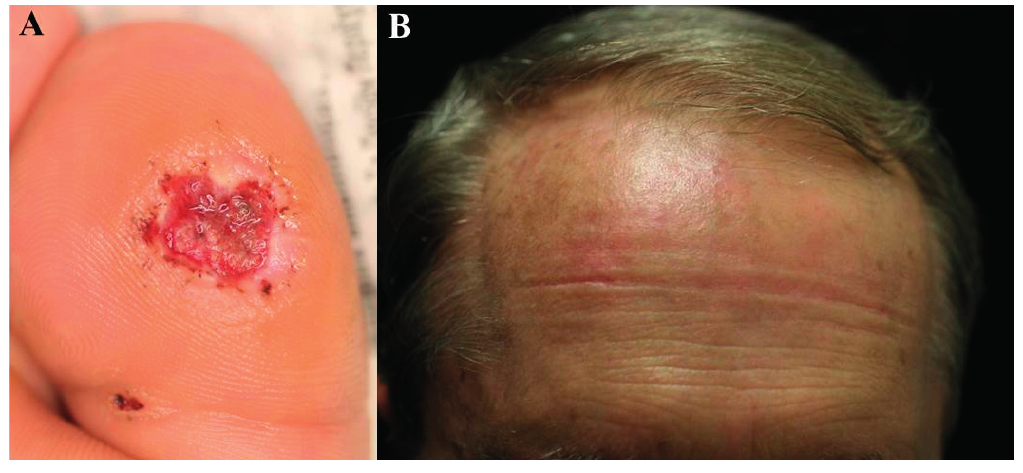
Figure 1. Side effects of PDT treatments. ( A ) Ulceration on the great toe after treatment of a wart with ILI-PDT; and ( B ) Diffuse mild erythema on the forehead after first treatment session of actinic keratosis with chlorophyll-PDT. ILI: intralesional injection; PDT: photodynamic